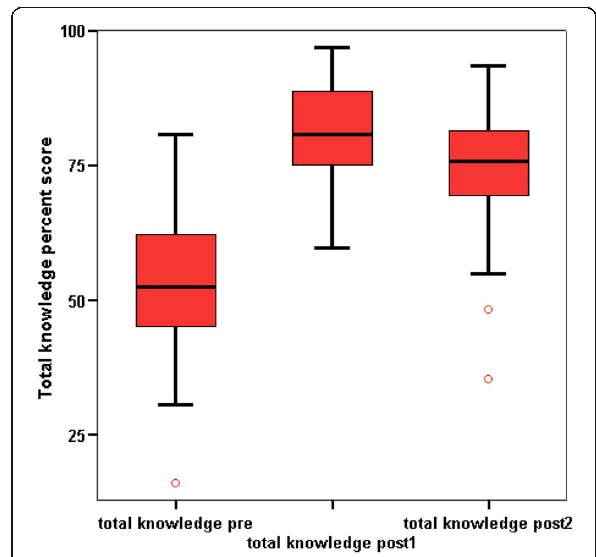
Fig. 1 Median total knowledge percent score before and after the education sessions